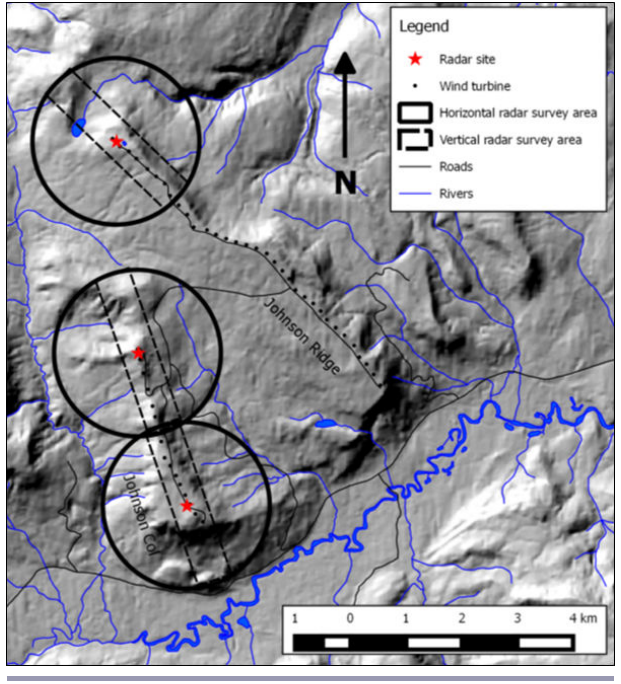
Fig. 1 . Position and orientation of the radar sites surveyed from 2008 to 2012 in relation to the topography of the ridgelines at the Dokie I Wind Energy Project in northeast British Columbia (55°41'28"N / 122°18'06"W). The 1.5 km radius circles represent the area of coverage for the surveillance (horizontal) radar. The dashed rectangular boxes represent the area of coverage for the vertical